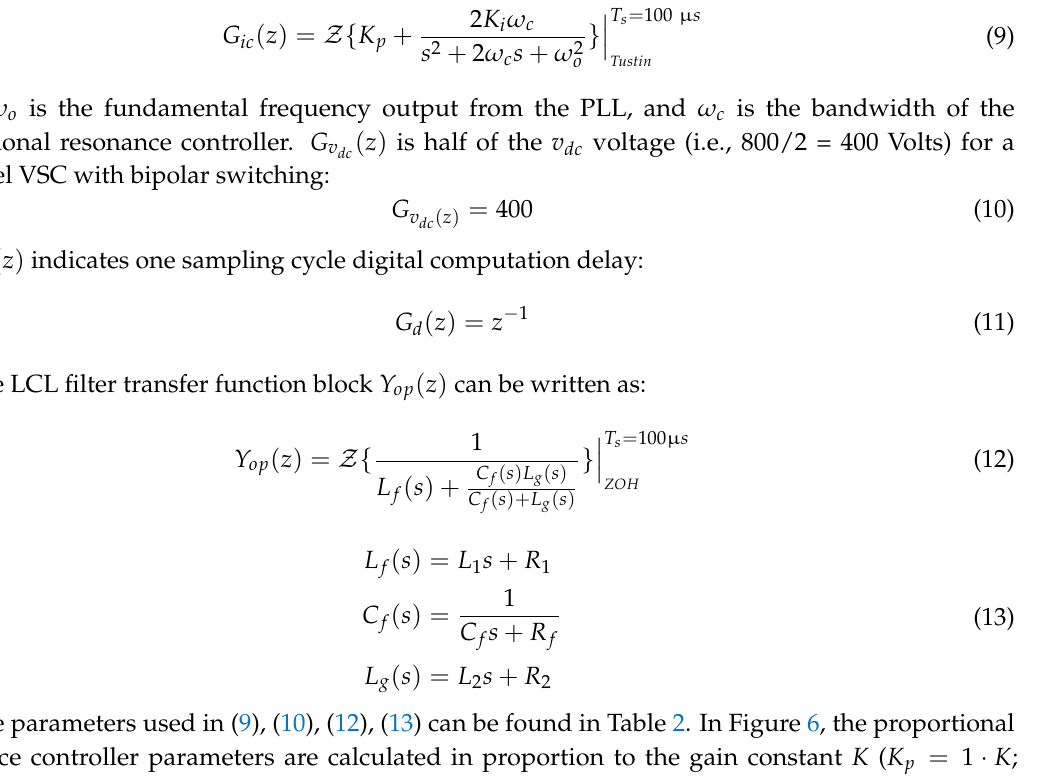
Figure 5. VSC Z Domain Current Control Loop Transfer Function